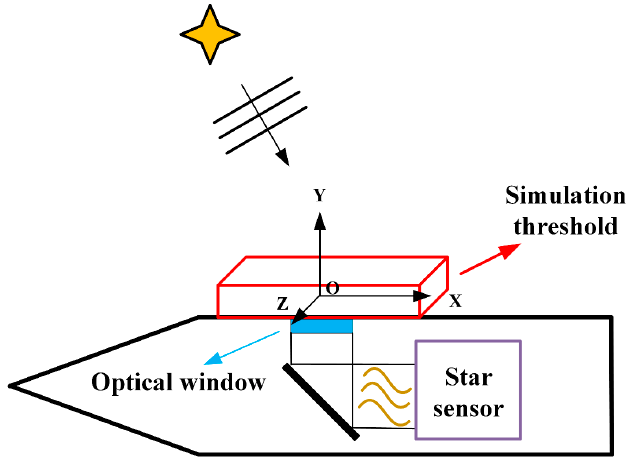
Figure 2. Schematic diagram of simulation threshold of density proxy model.